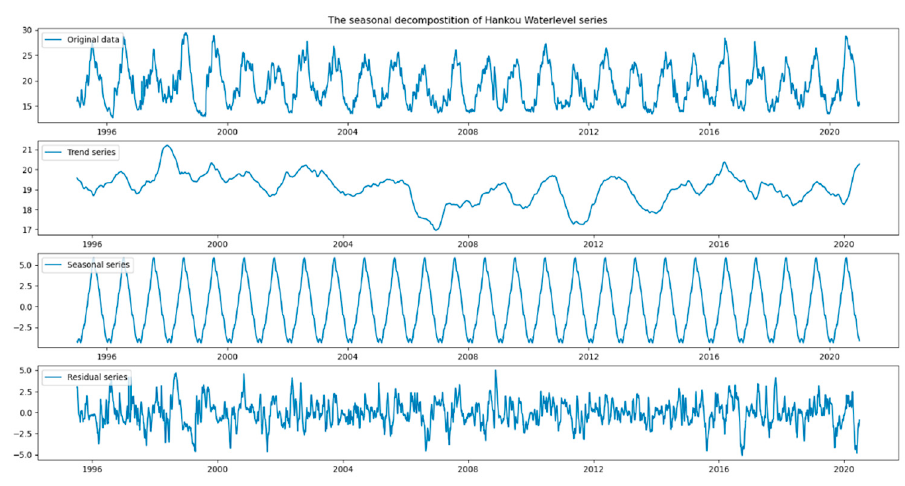
Figure 4. The seasonal decomposition of Hankou water level series.